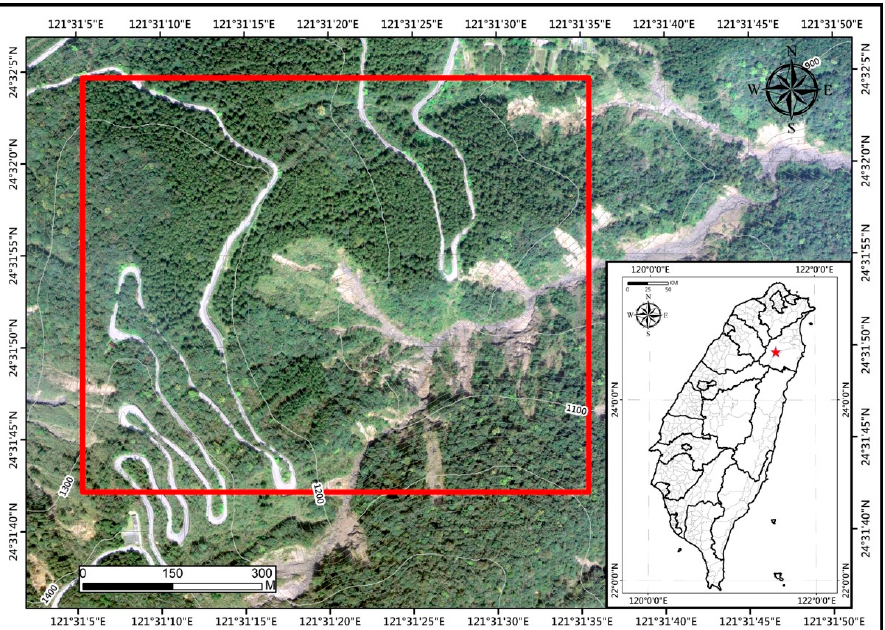
Figure 2. Aerial photo showing location of the deep-seated landslide in the Lantai study area with landslide scars and ground erosion, and the aerial photo was acquired on 27th September 2017 taken by ADS40 sensor at an elevation of approximately 4086~4091 m above ground level (AGL) (the WGS 84 coordinates were used). The red star marks the location of study area.